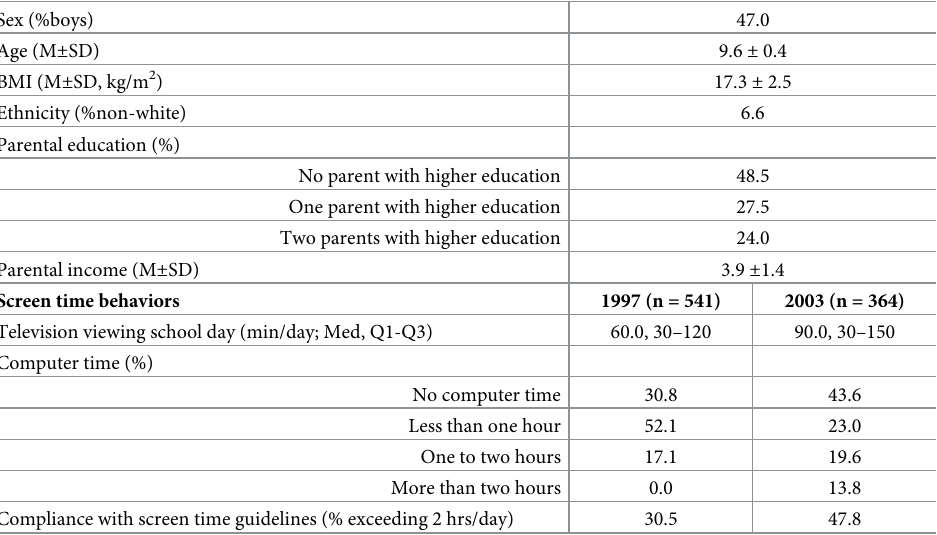
Table 1. Demographic characteristics of the sample (Baseline information, n =